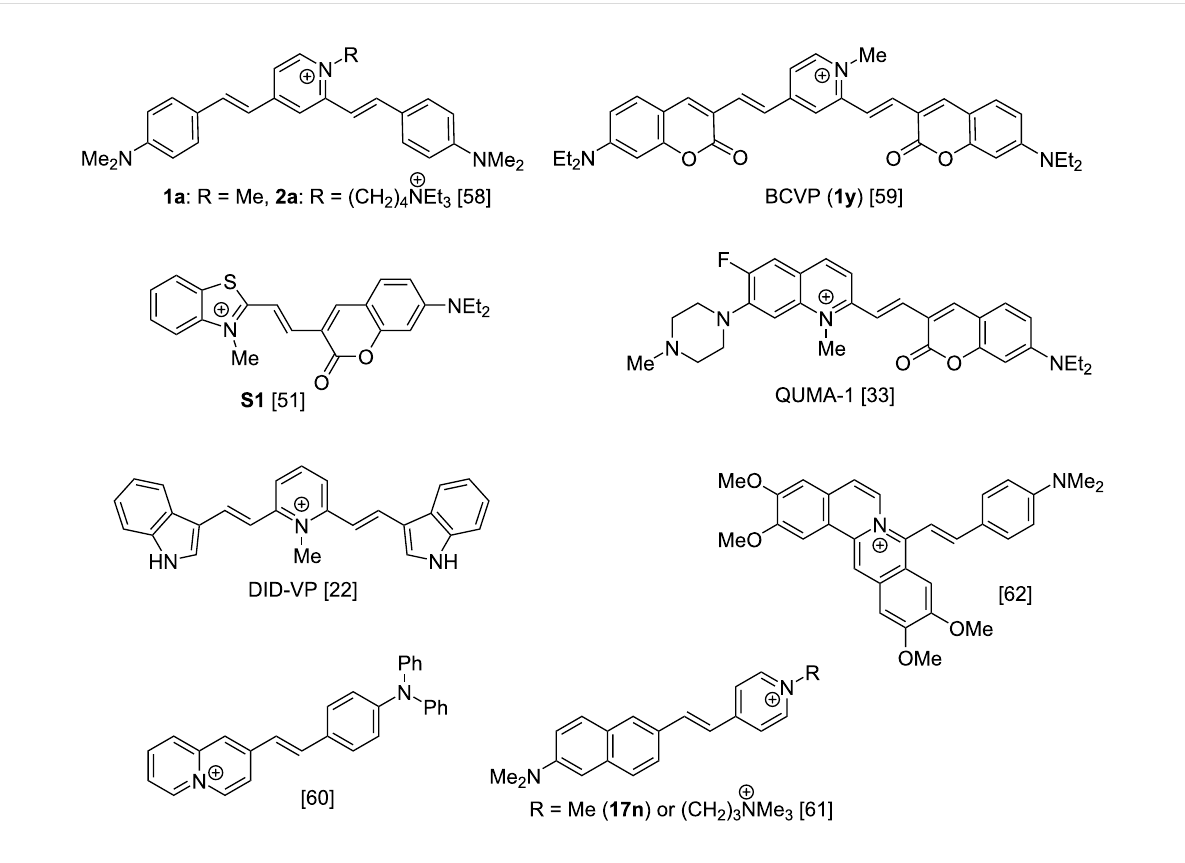
Figure 1: Some di- and mono-styryl dyes previously reported as fluorescent “light-up” probes for G4-DNA and RNA. Counter-ions are omitted for the sake of